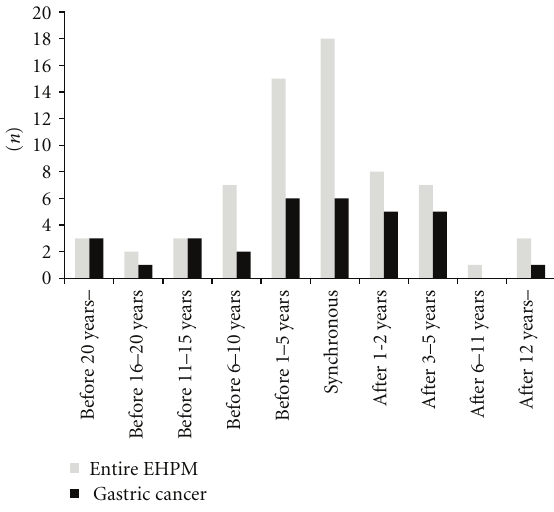
Figure 2: Distribution of EHPM according to time-flow. The EHPMs distributed most in synchronous cases, secondary dis- tributed within before or after 5-years from hepatectomy. Longer the time is away from hepatectomy, more less the EHPM cases have been detected. The same tendencies were observed in urinary tract and breast